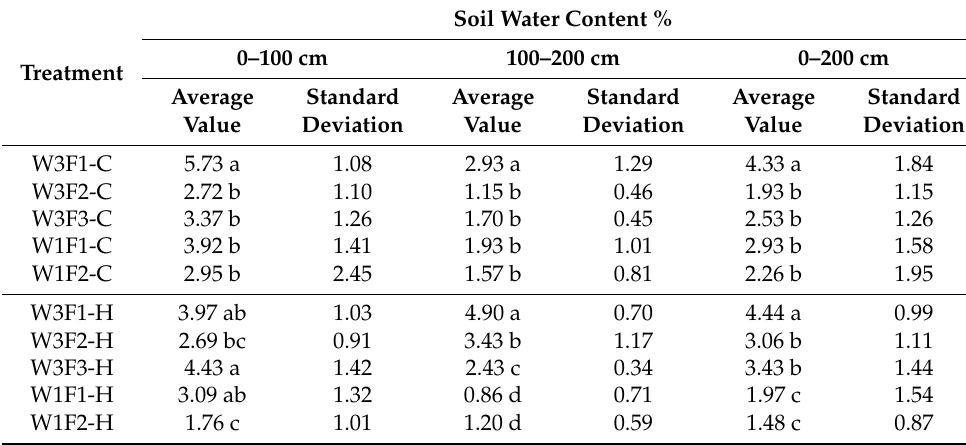
Table 2. Soil moisture content between different treatments ( p <